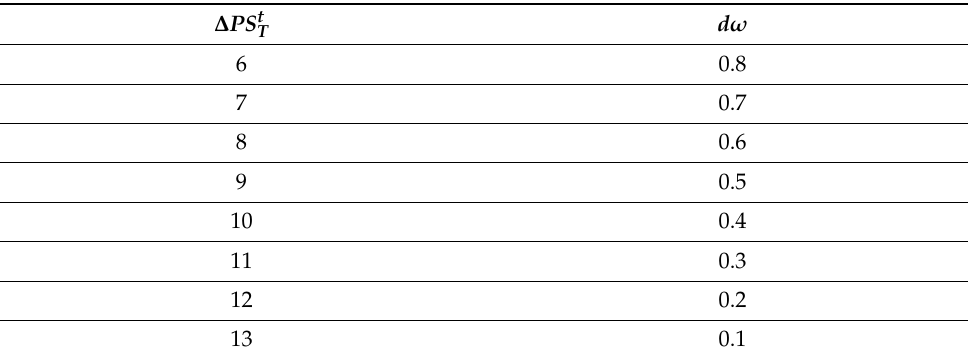
Table 3. Decrease in weight differently defined according to the predicted speed